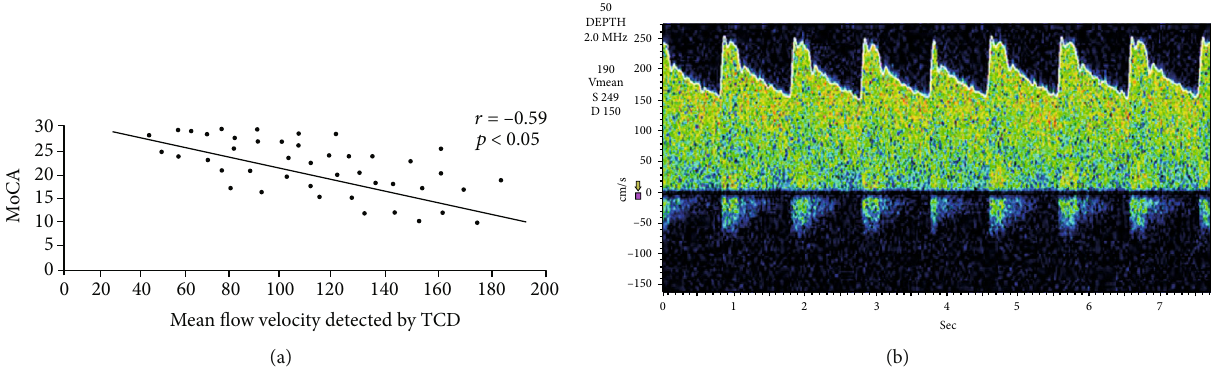
Figure 3: Correlation of mean fl ow velocity and MoCA. Table 2: Demographics, risk factors, and initial clinical scales at the